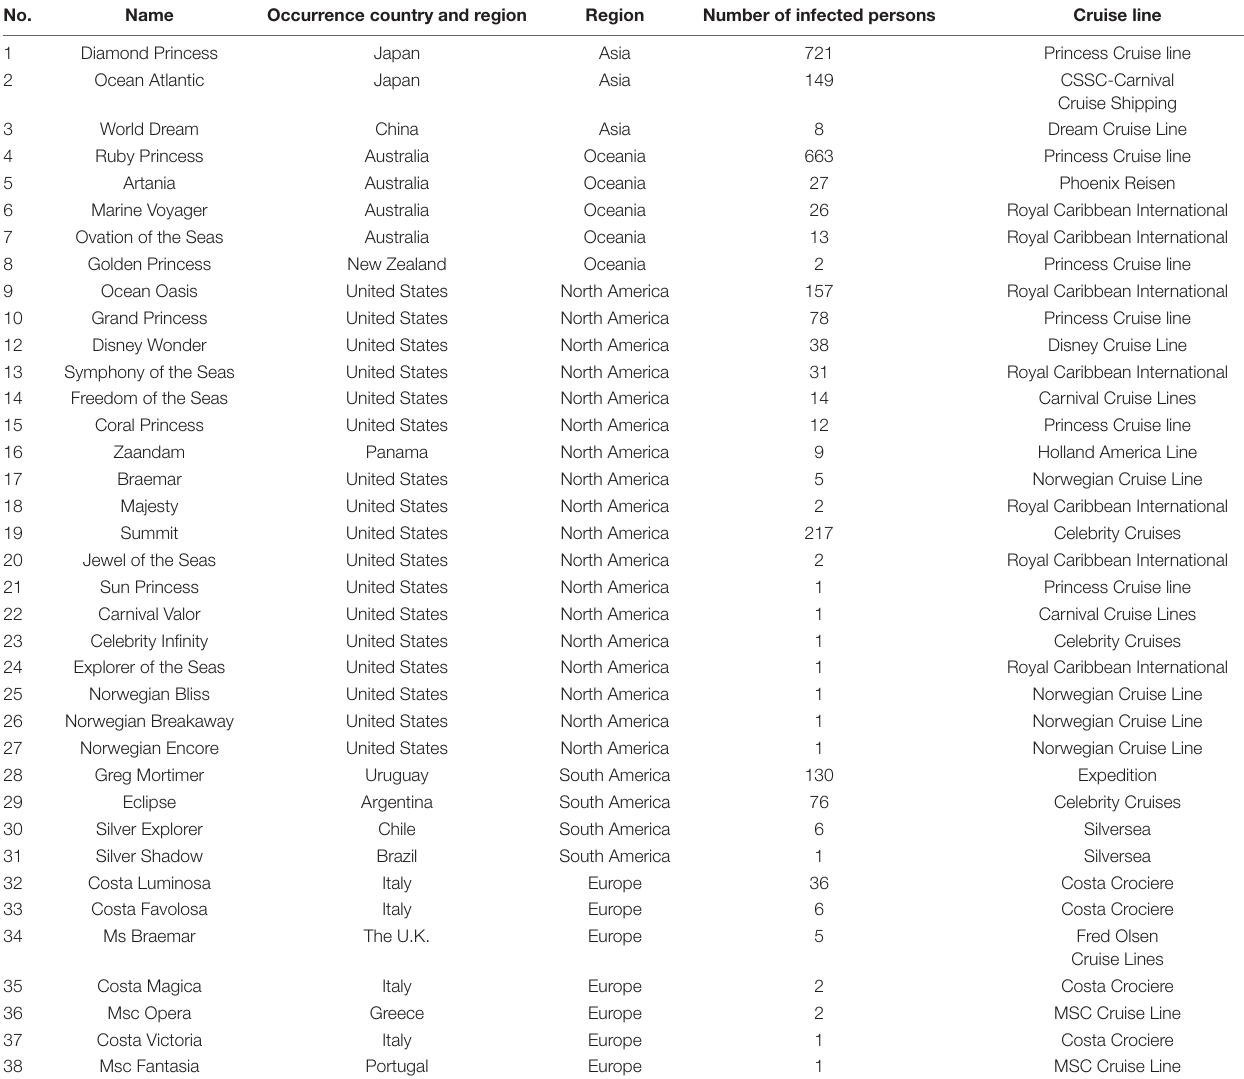
TABLE 3 | Cruise ships with pandemic